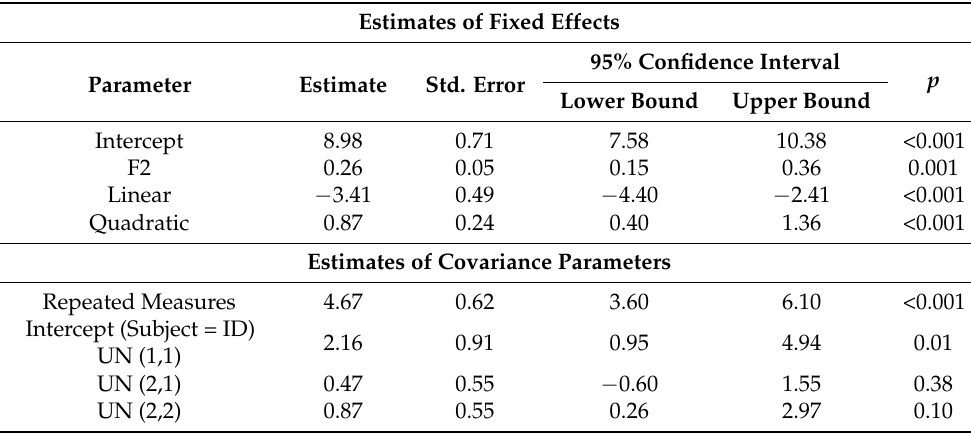
Table 7. The final mix model including the significant